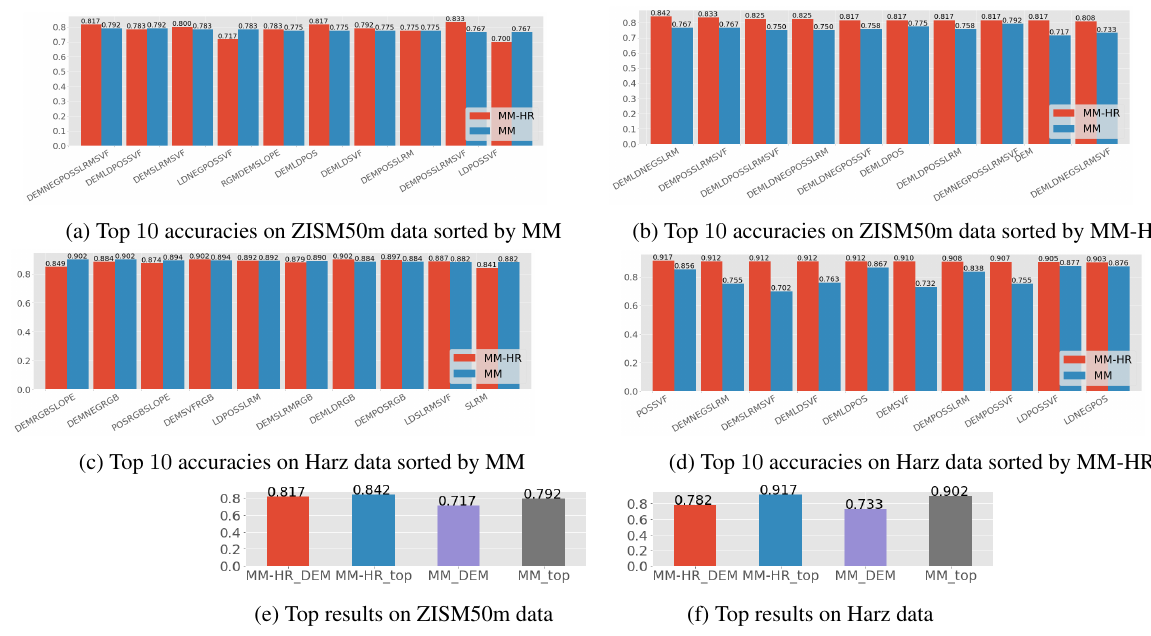
Figure 10. Top 10 accuracies among different combinations for both